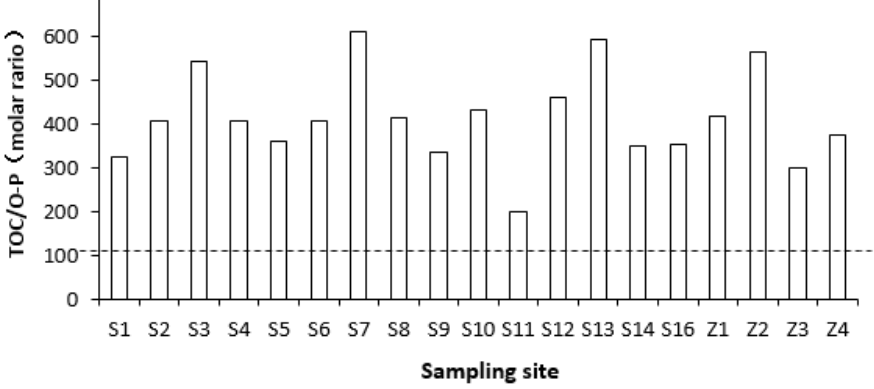
Figure 6. Atomic ratios of TOC and O-P in surface sediments of Daya Bay.